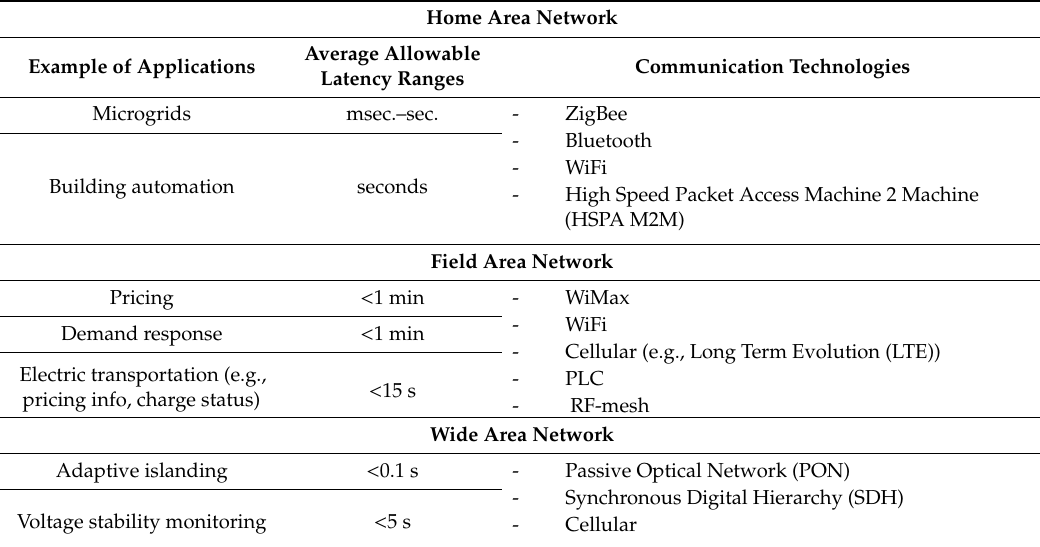
Table 1. Home Area Network (HAN), Field Area Network (FAN), and Wide Area Network (WAN) layers’ applications, allowable delays, and utilized communication